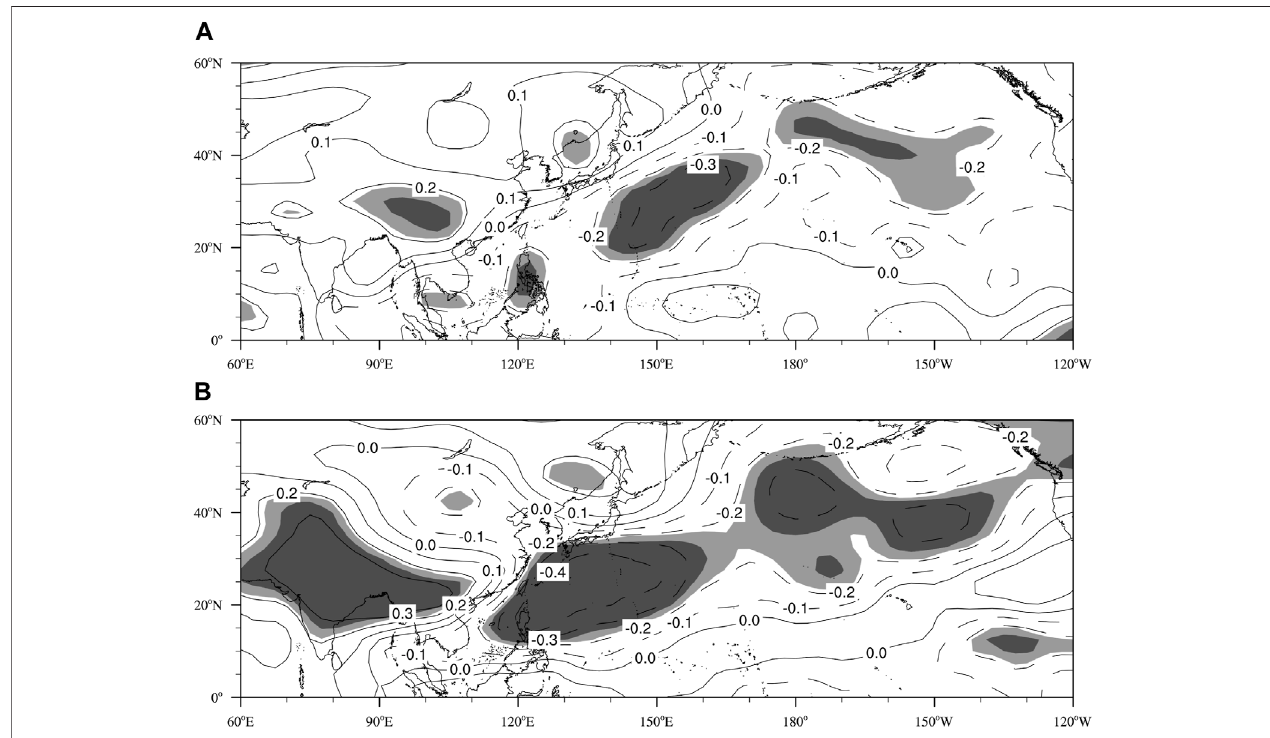
FIGURE7| CorrelationbetweenthemeanSeptember500 – 200 hPa T ’ and (A) theAPOIand (B) theSCPIfor1961 – 2020(shadingindicatesareassigni fi cantatthe 95% (dark) and 90% (light) con fi dence level).